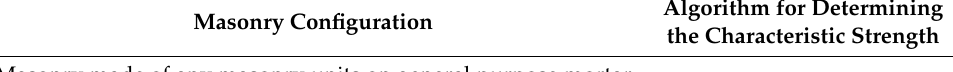
Algorithm for Determining the Characteristic